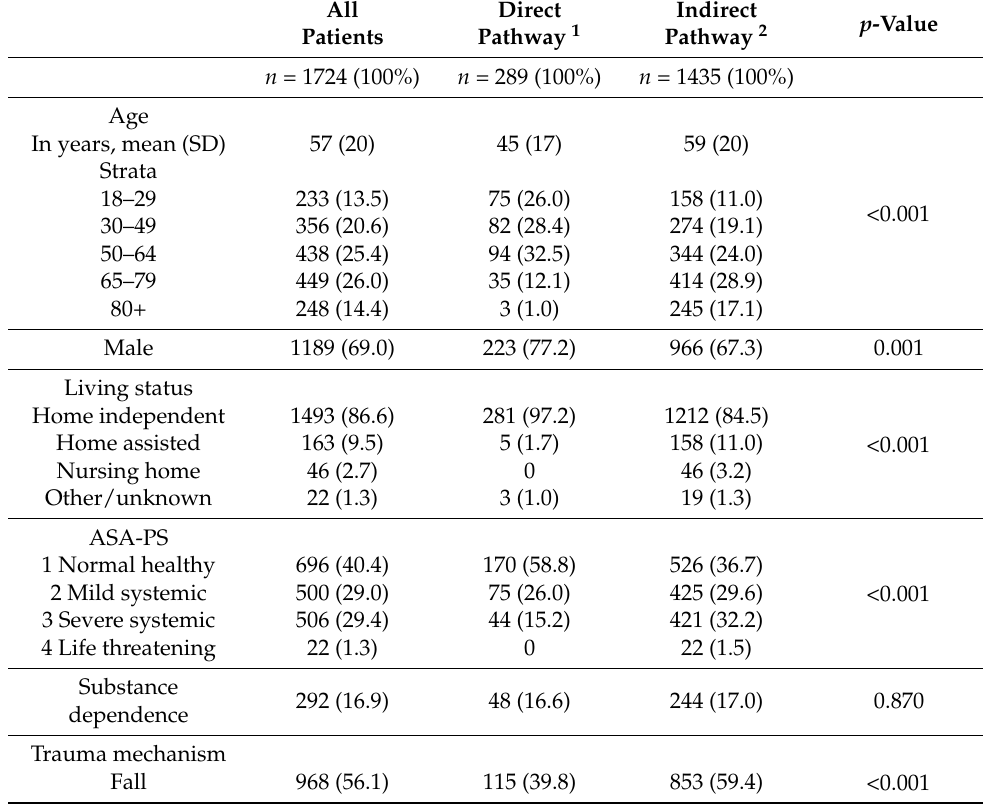
Table 1. Patient and injury